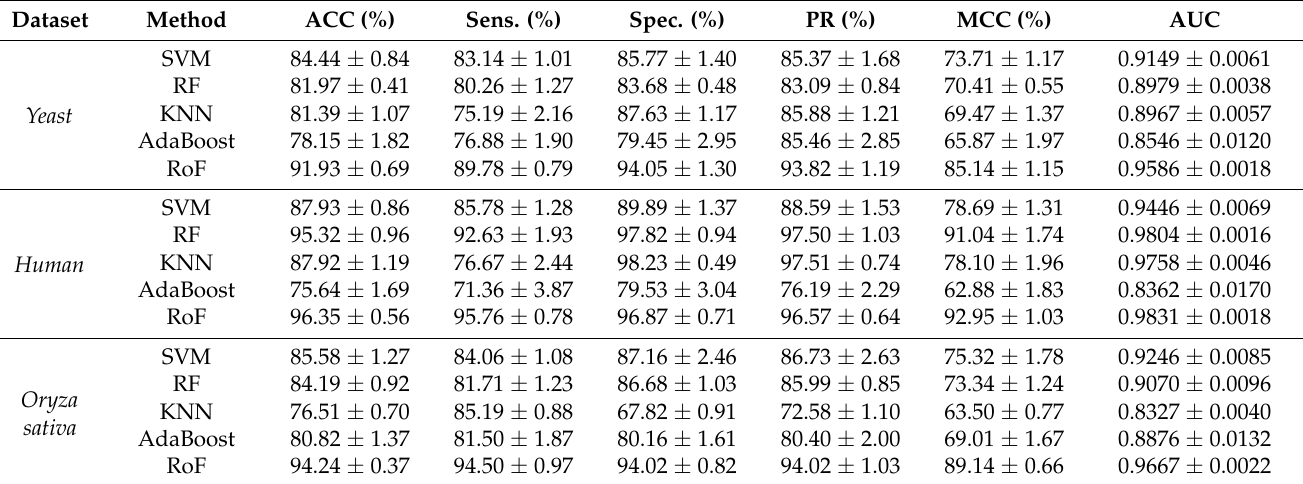
Table 4. Predictive performance comparison among four different